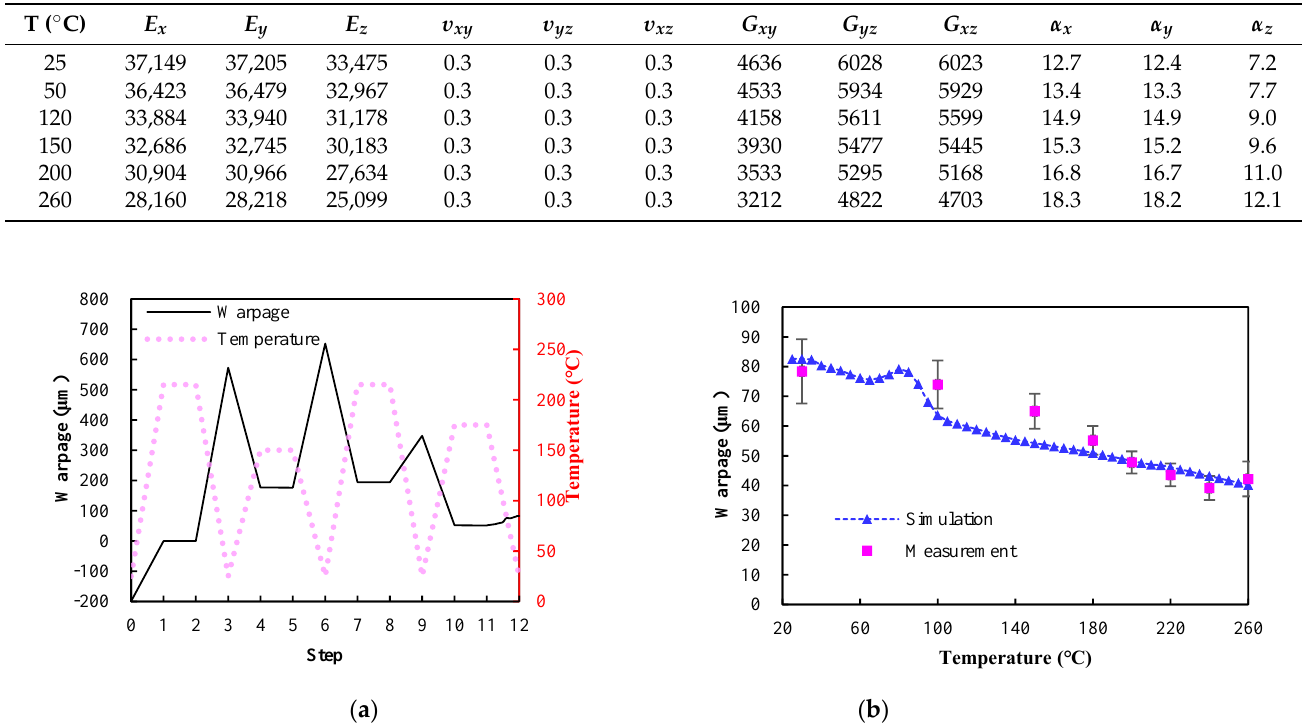
Figure 12. Warpage evolution: ( a ) from die bond to mold cure process; ( b ) during increasing temperature process.